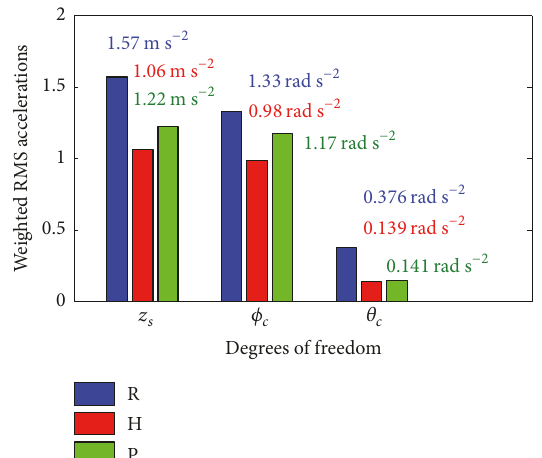
Figure 11: The weighted RMS acceleration responses under an excitation of the off-road terrain of Grenville loam.